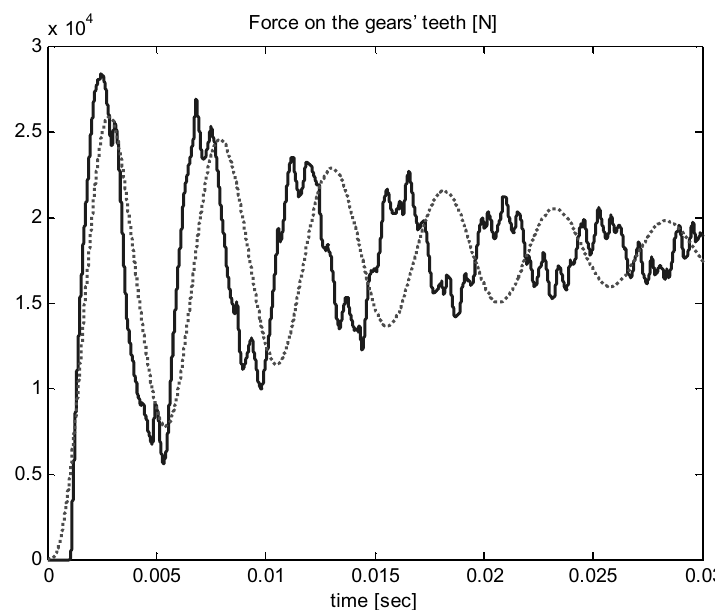
Fig. 14. Force on the gears teeth when damping is reduced by half. Solid – transfer function model, dotted – lumped